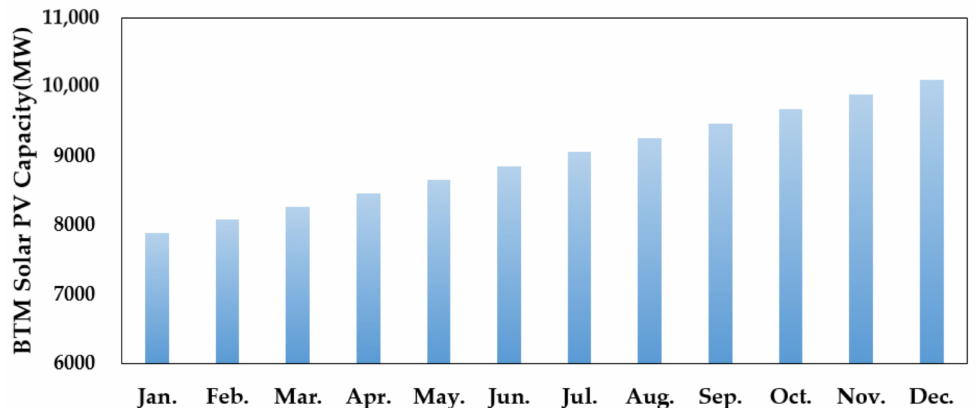
Figure 7. The capacity of the BTM solar PV generators estimated based on regression in 2019.